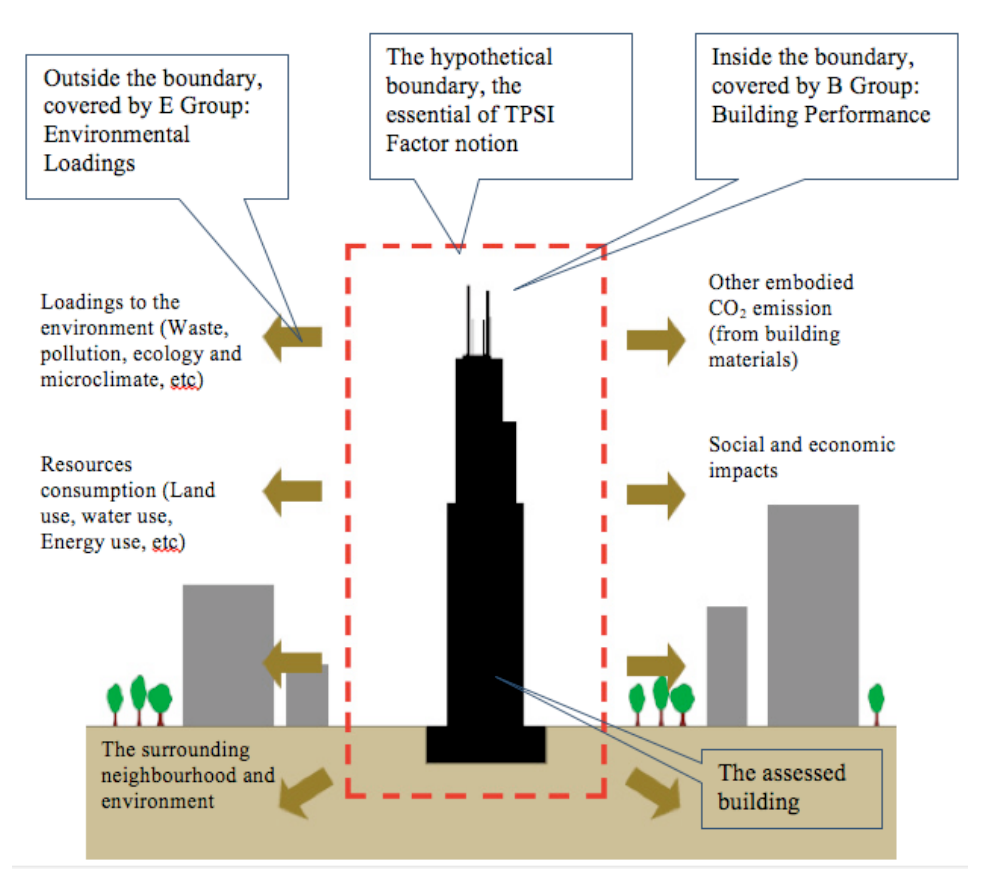
Figure 2. The mechanism behind TPSI